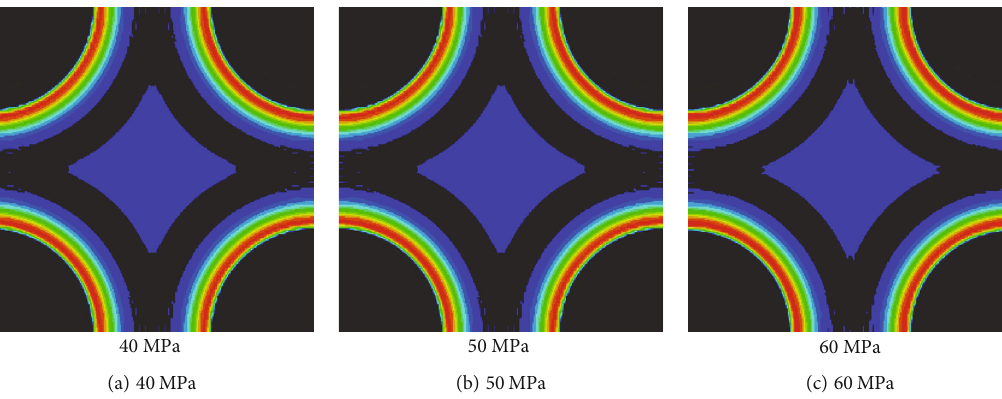
Figure 29: Contact stress cloud diagram of rock slab under di ff erent in situ stresses.